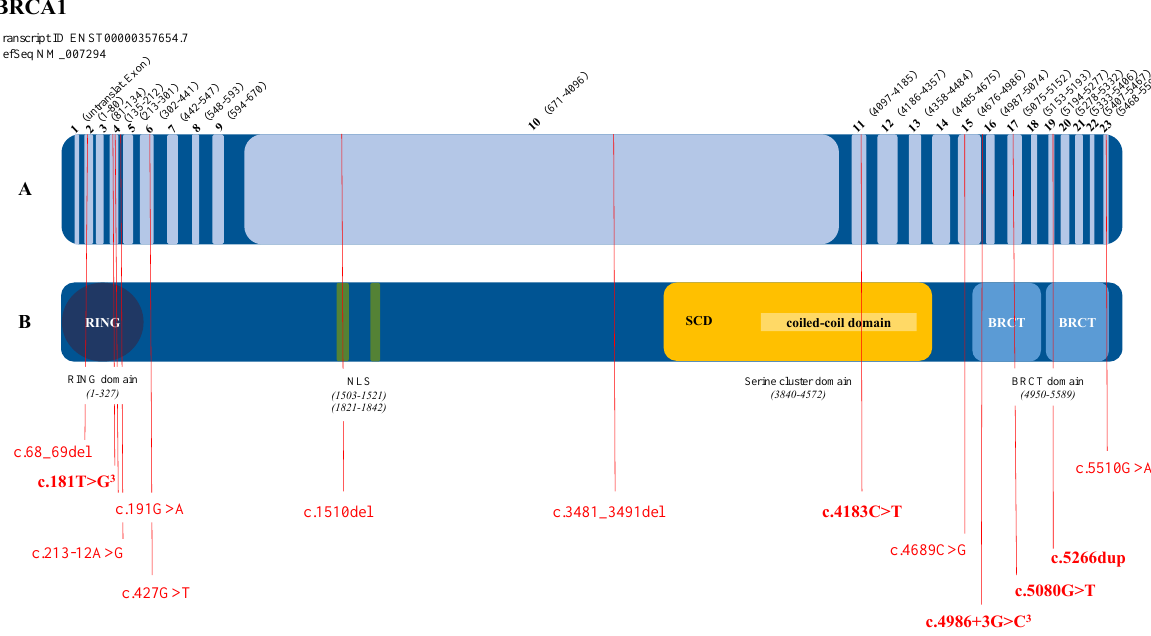
Figure 1. Localization of detected pathogenic variants in the BRCA1 gene (RefSeq NM_007294). ( A ) Gene representation with exon and intron indication (light and dark blue, respectively)—bold numbers: exon numbering; numbers in parentheses: cDNA positions. ( B ) Protein representation—different colored shapes: functional domains; RING: really interesting new gene domain; NLS: nuclear localization sequence; SCD: serine cluster domain; BRCT: BRCA1 C-terminus domain. Pathogenic variants are indicated in red; bold notation of pathogenic variant: dual occurrence; superscript three: triple occurrence.